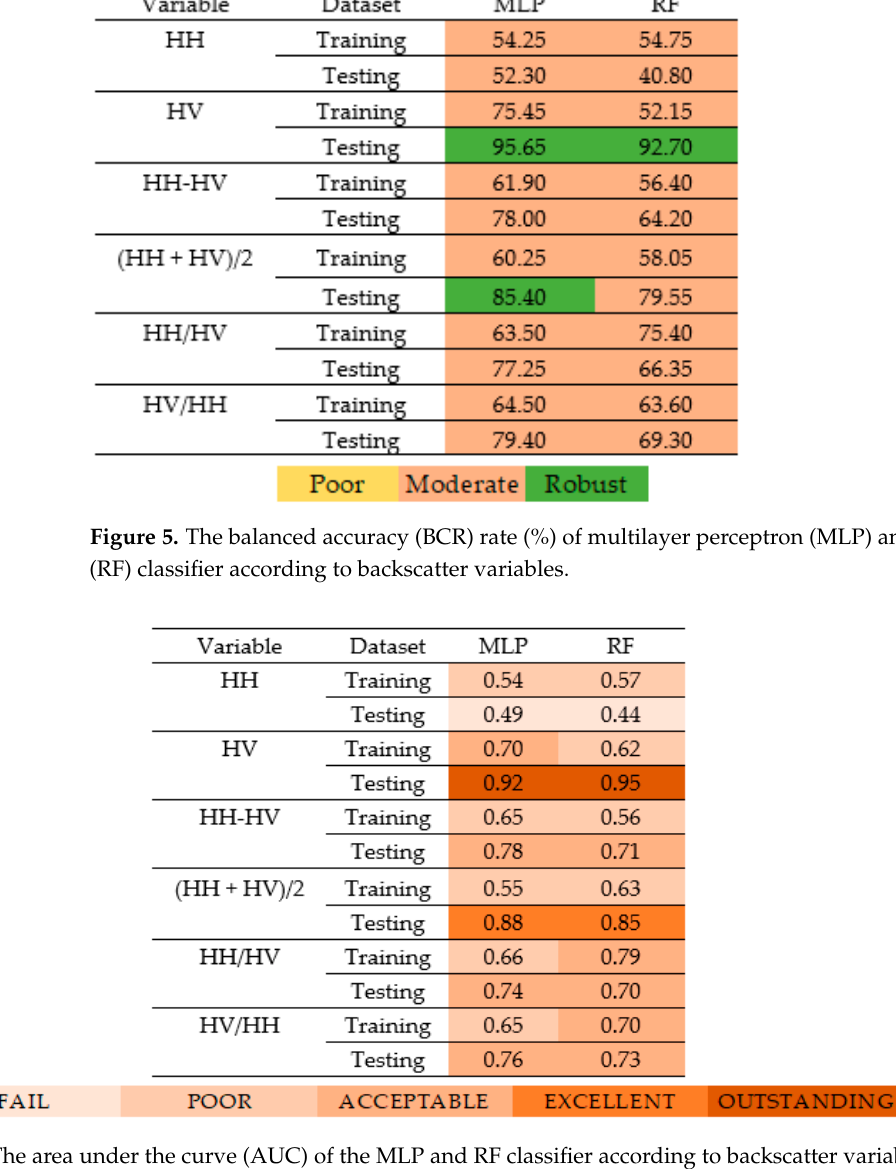
Figure 6. The area under the curve (AUC) of the MLP and RF classifier according to backscatter variables.